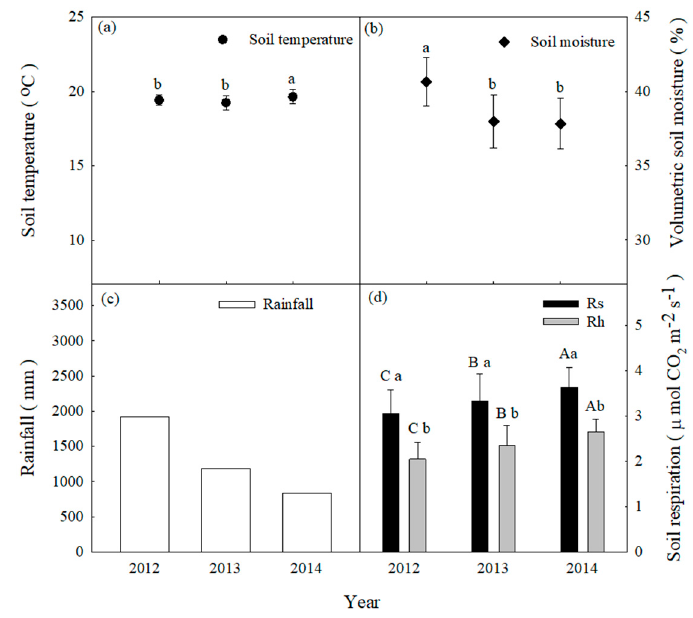
Figure 9. Mean values of ( a ) soil temperature, ( b ) soil moisture, ( c ) sum of rainfall, ( d ) mean soil respiration (Rs), and heterotrophic respiration (Rh) in the summer season (June–August). Different capital letters indicate differences among years in the same treatment at p < 0.05. Different lowercase letters indicate differences between treatments in the same year at p < 0.05. Error bars indicate standard deviations (SD).